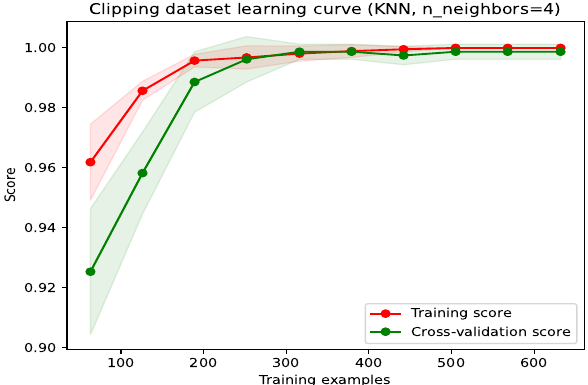
Figure 13. Clipping training set learning curve scatter diagram.